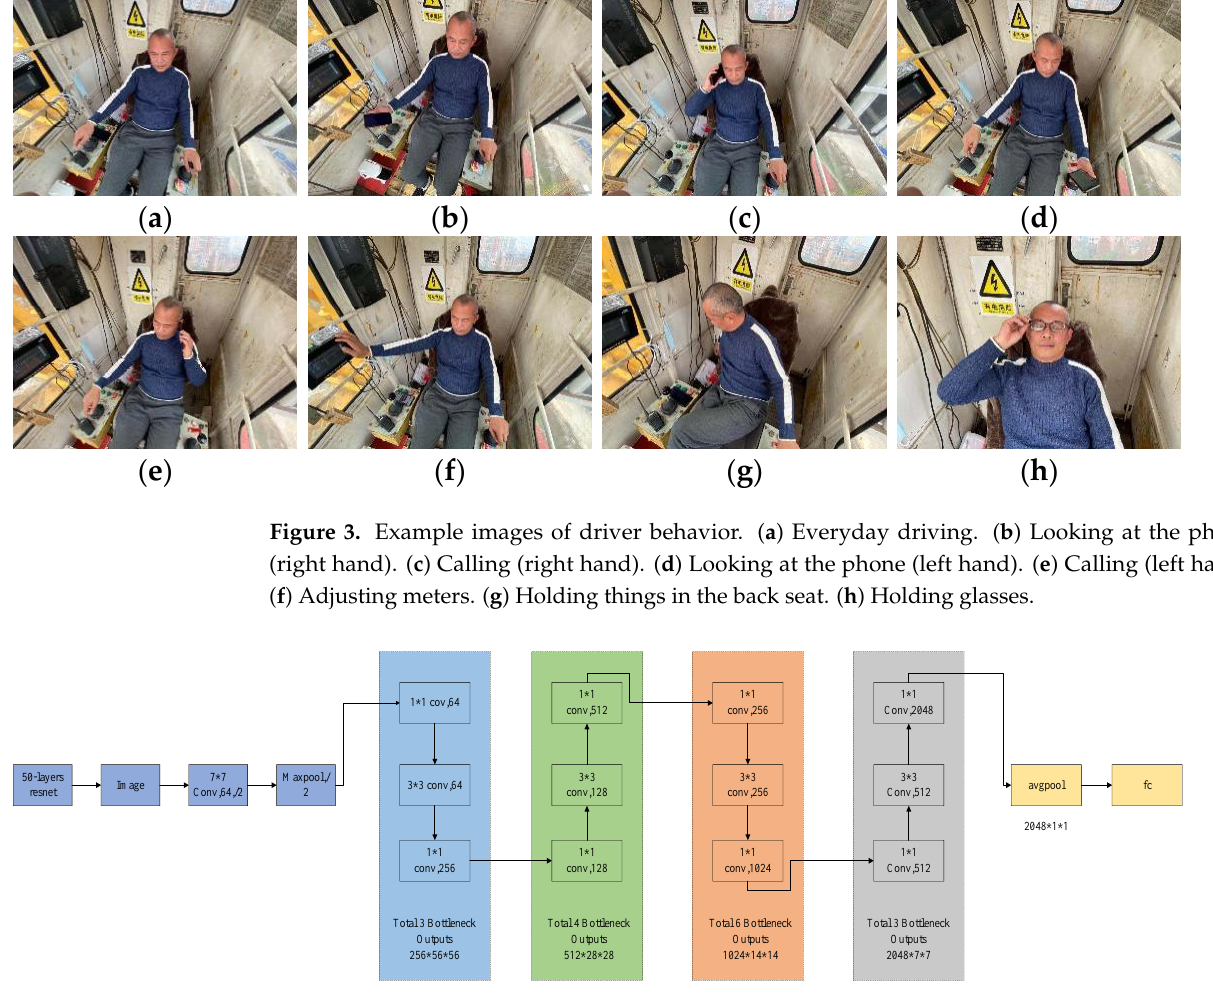
Figure 4. ResNet50 network structure.